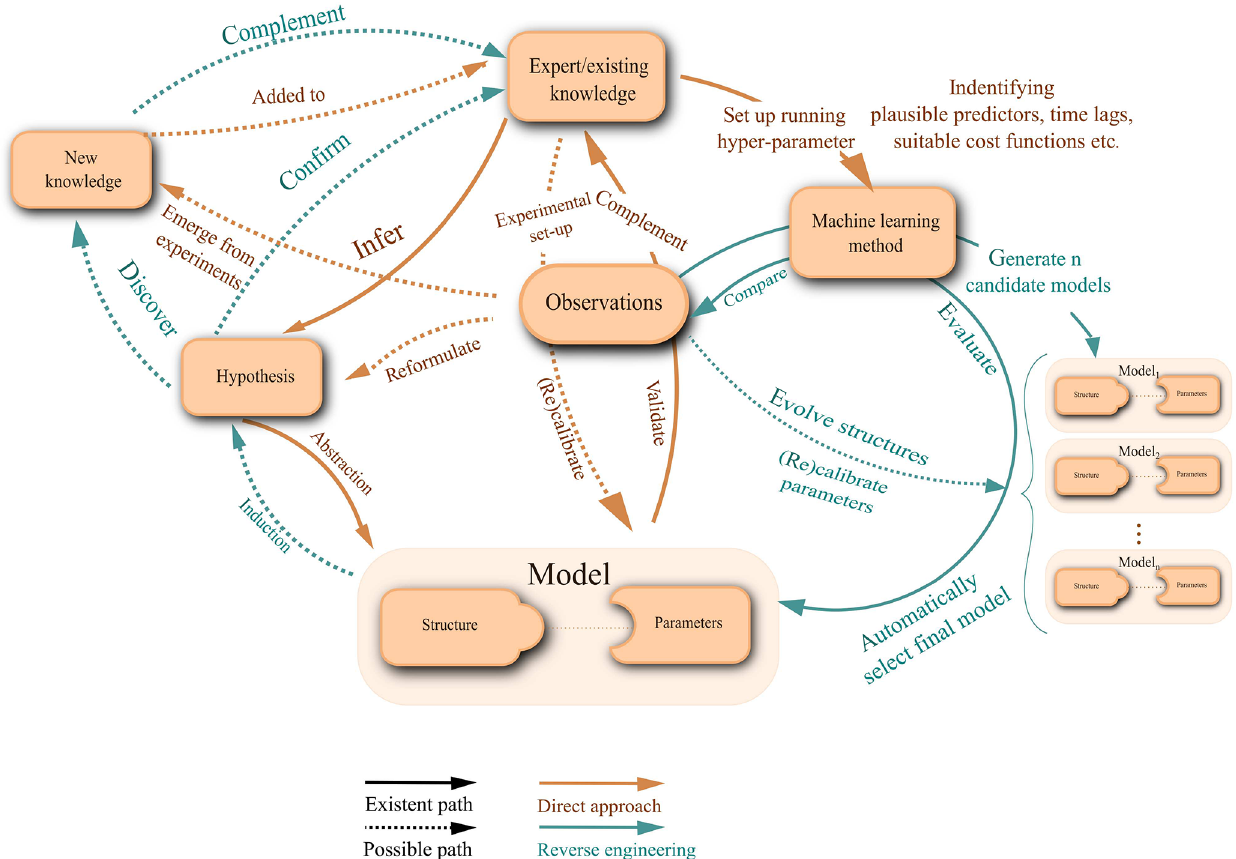
Figure 1. Direct approach and reverse engineering in model development for describing dynamical systems. Existing and possible steps needed in the process of building a model. For the direct approach, the process starts with the building of a hypothesis from existing knowledge. The hypothesis is then the subject of abstraction and is summarized in a mathematical model that has two components: the structure and the parameters. The mathematical model can be translated into a computational form that will generate predictions. Depending on how well the predicted values manage to recreate the available observations, the model’s parameters are calibrated or, if the general trends are missed, there might be a need for structural reformulation. On the other hand, in the reverse engineering approach, a machine learning method is used to generate a set of candidate models that are then compared with the available observations and which according to the prediction capacity may have to go through structural changes by automatic evolution or through a final parameter adaptation. From the set of evolved models, the best model in terms of prediction capacity is chosen and its structure will be the basis for hypothesis building, as an expert would try to explain why a specific structure was automatically evolved and whether the structure of the model can be explained from the studied system-intrinsic processes. If that is the case, and the structure has not emerged randomly, the conclusions can be compared with the existing knowledge which can be reconfirmed, or new aspects of the studied system might be brought to